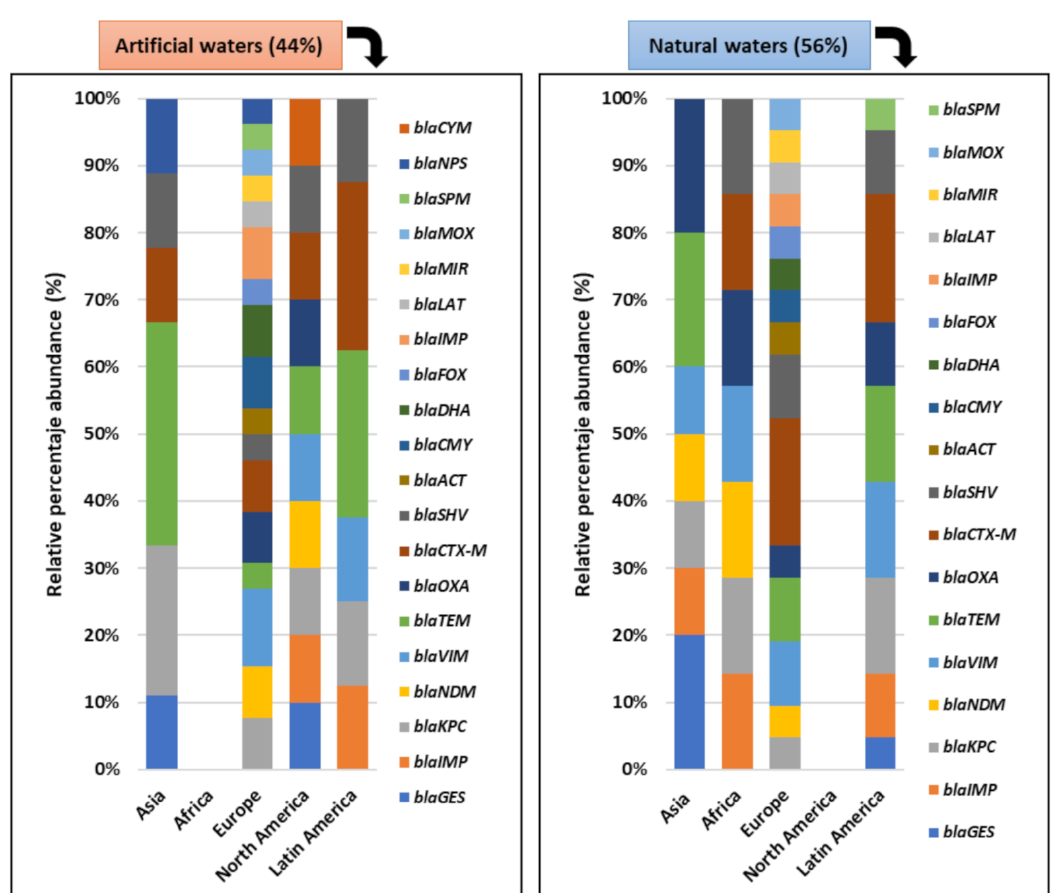
Figure 7. Abundance of bla genes in natural and artificial waters. blaCYM (substrate specificity for cephalosporins), bla NPS (have partial hydrolyzing abilities against penicillins and cephalosporin), bla SPM confers resistance to carbapenem), bla MOX (plasmid-mediated AmpC-type beta-lactamases), bla MIR (confer resistance to oxyimino- and alpha-methoxy beta-lactams), bla LAT (confer resistance to cephamycin), bla IMP (confer resistance to carbapenem, cephalosporin, cephamycin, penam, penem), bla FOX (conferred resistance to broad-spectrum cephalosporins and cephamycins), bla DHA (confer resistance to cephamycin and cephalosporin), bla CMY (confer resistance to cephamycin), bla ACT (confer resistance to actinomycin), bla SHV (confer resistance to carbapenem), bla CTX (confer resistance to cefotaxime acid), bla OXA (confer resistance to oxazocillin), bla TEM (confer resistance to termocilline), bla VIM (confer resistance to cephamycin), bla NDM (confer resistance to penem), bla KPC (confer resistance to monobactam, carbapenem, cephalosporin, penam), bla IMP (confer resistance to penam), bla GES (confer resistance to